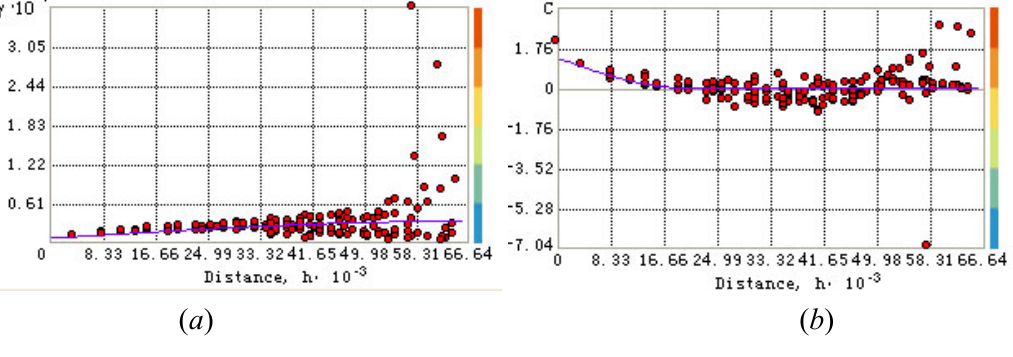
Figure 3. Fitting the spherical model to the experimental: ( a ) variogram and ( b ) covariance temperature